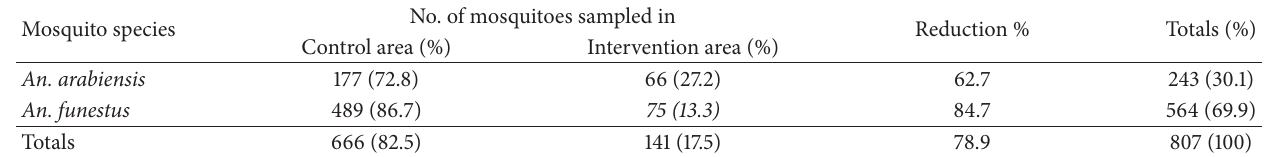
Table 1: Indoor resting patterns of Anopheles mosquitoes by species at Kanyaboli .